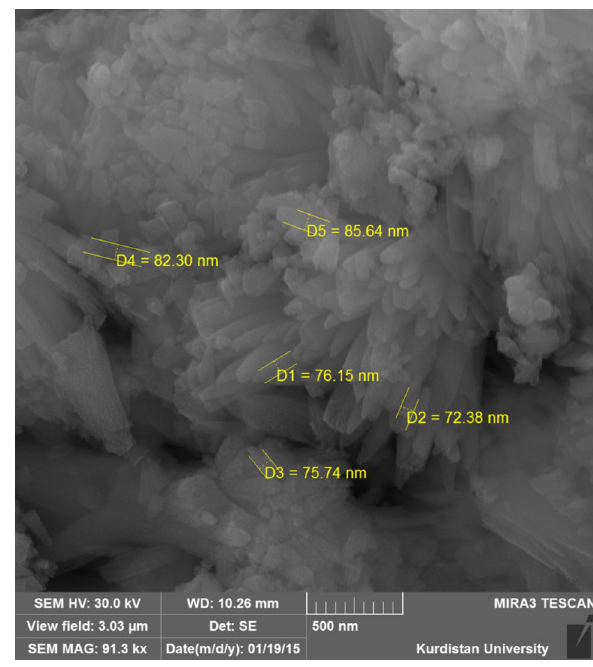
Fig. 1 SEM image of synthesized HA with